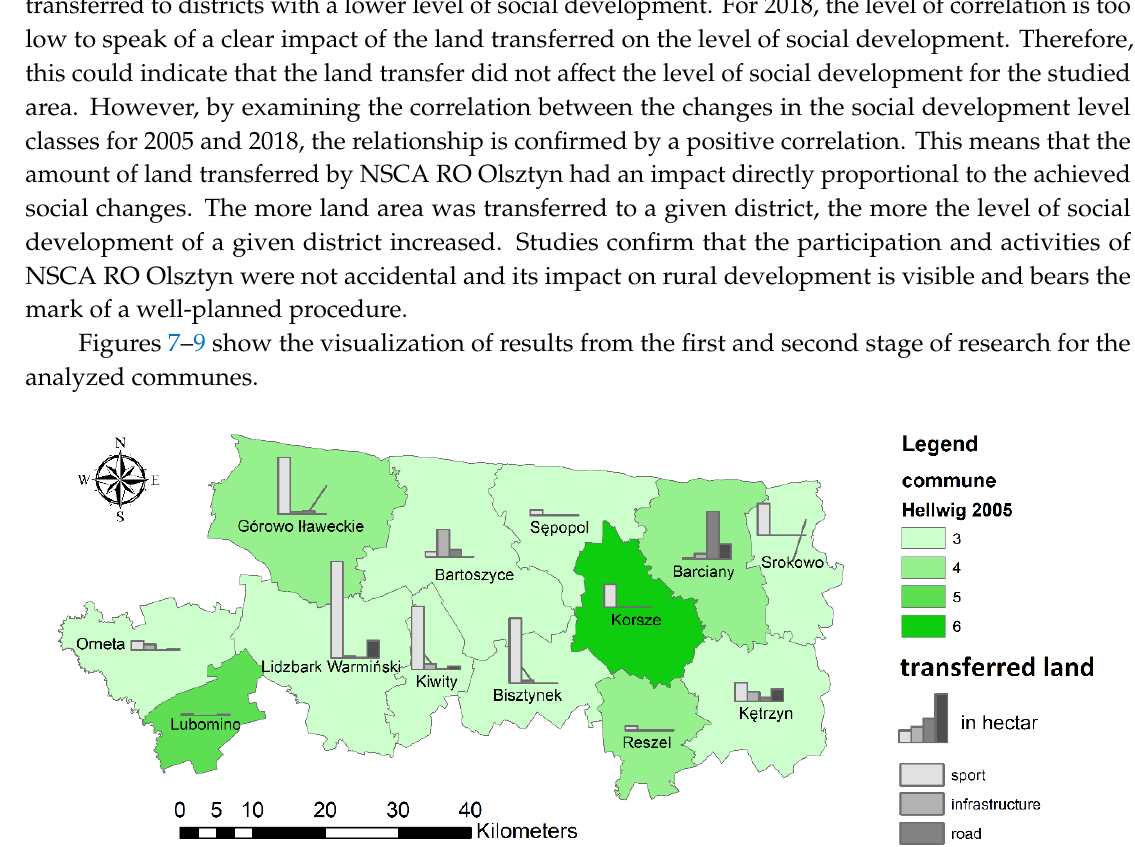
Figure 9. Change in the social development classes in the period from 2005 – 2018 compared to the area of land transferred for various purposes. Data for communes. Pearson correlation coefficient values obtained for communes are included in Table 5. Table 5. Pearson correlation coefficient values for all analysis variants/communes. Hellwig 2005 Hellwig 2018 Hellwig 2005–2018 Total area